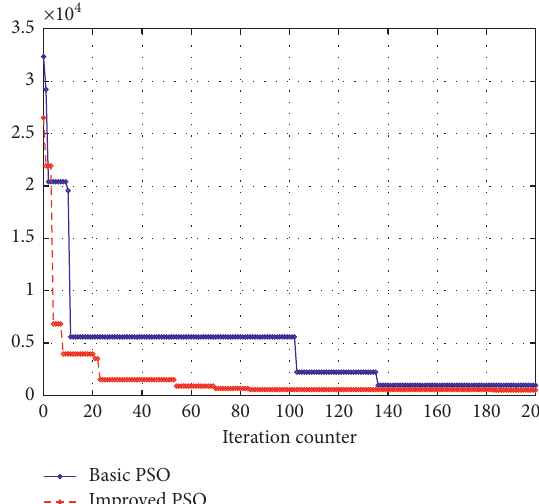
Figure 6: Curve of objective function J with iteration